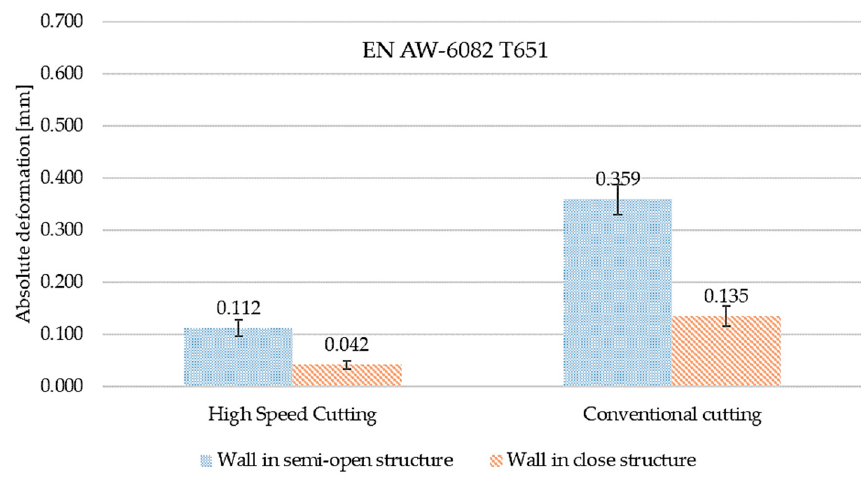
Figure 17. The comparison of maximum absolute deformation values depending on finishing machining and the type of structure for the EN AW-6082 T651 aluminium alloy.